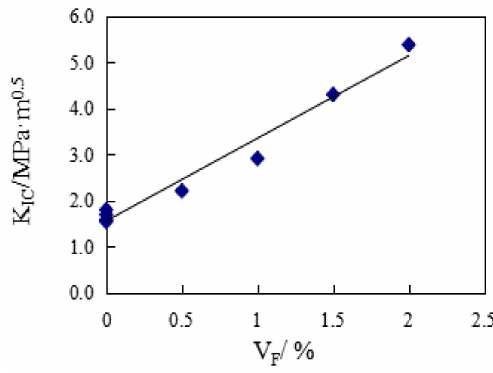
Figure 3. The effect of V F on K IC